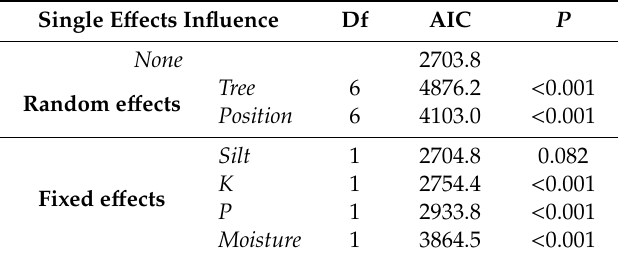
Table 3. Generalized Linear Mixed Model e ff ects Chi-squared test. First row shows the optimal model Akaike Information Criteria (AIC). Df: Degrees of freedom. P : Significance level.